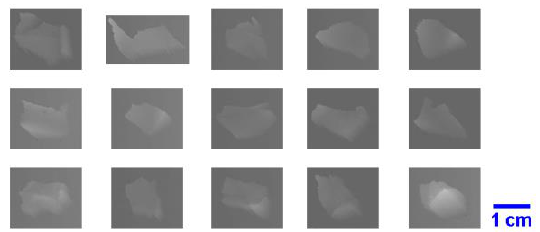
Figure 4. Three-dimensional (3D) grayscale images of tested objects.